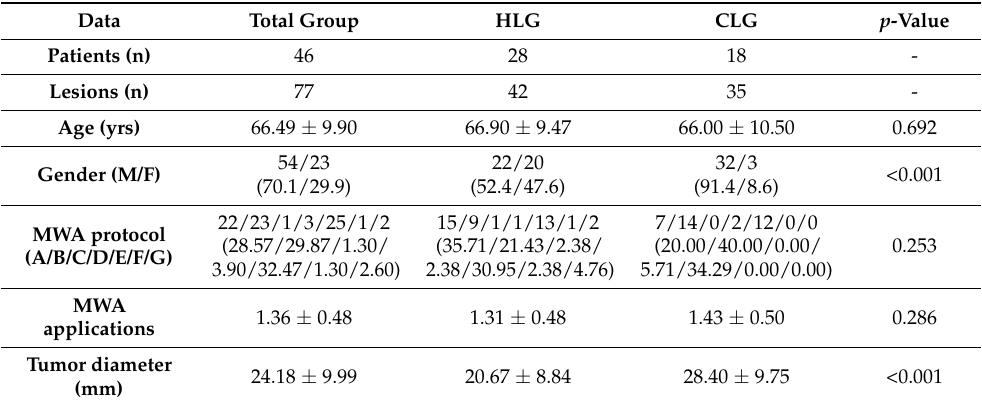
Table 1. Demographic and clinical data of the selected patients and lesion after MWA.